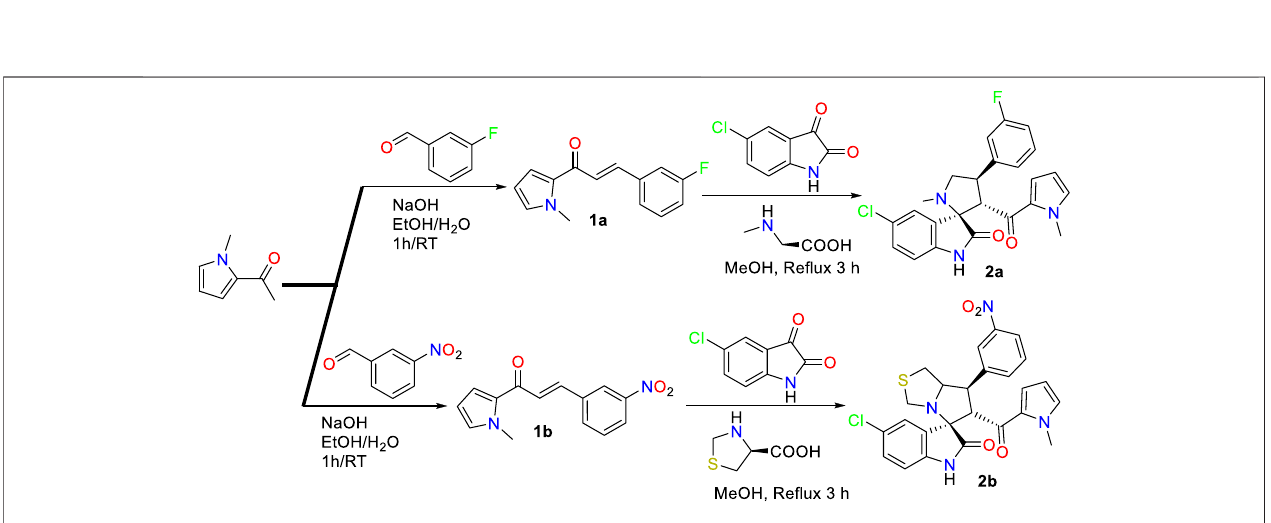
SCHEME 1 | Synthesis of the spirooxindole derivatives 2a,b